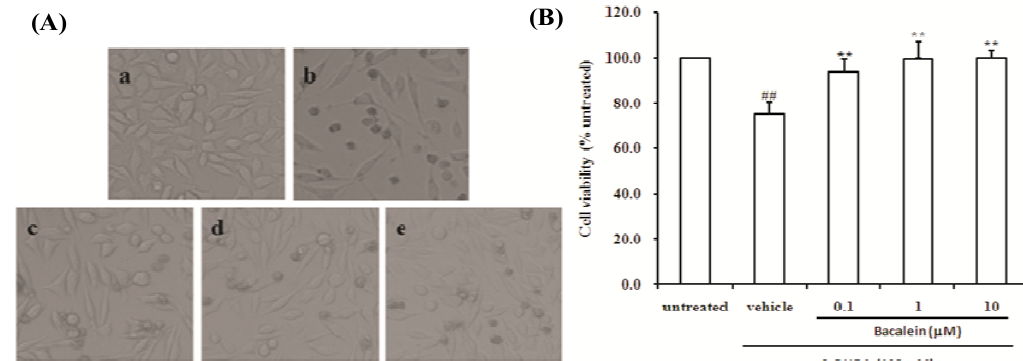
Figure 2. Effect of baicalein on the morphological changes and viability of SH-SY5Y cells induced by 6-OHDA. ( A ) Morphological changes were observed by light